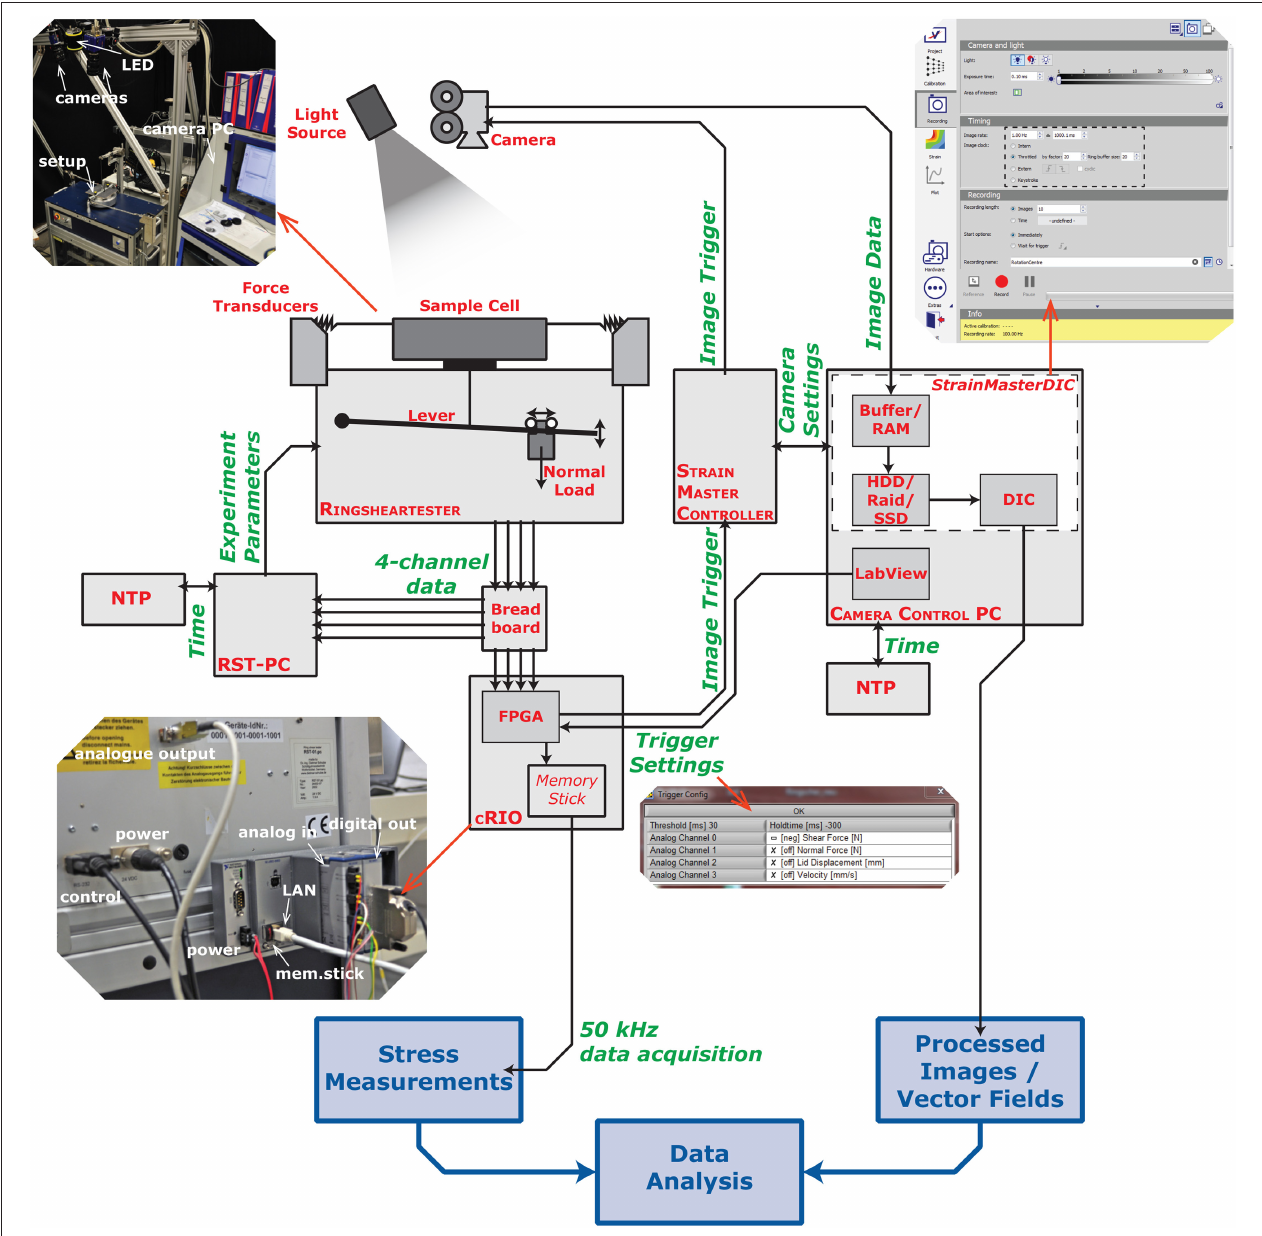
FIGURE 3 | Schematic diagram showing the setup and the connections to the monitoring system. The ring-shear-tester is controlled by a computer (RST-PC), which sets the parameters for the experiment (e.g., shear velocity, normal stress). The CompactRIO (cRIO) is connected to the output channels and provides the triggering and recording on all four channels ( F shear , F normal , 1 H , V L ). A second computer (Camera Control PC) is connected to the camera system which consists of a controller (StrainMaster Controller) and a software (StrainMasterDIC by LaVision). It supplies the settings for the camera (recording rate, exposure time,...) and stores the incoming image data for digital image correlation (DIC). All components are also listed in Table 1